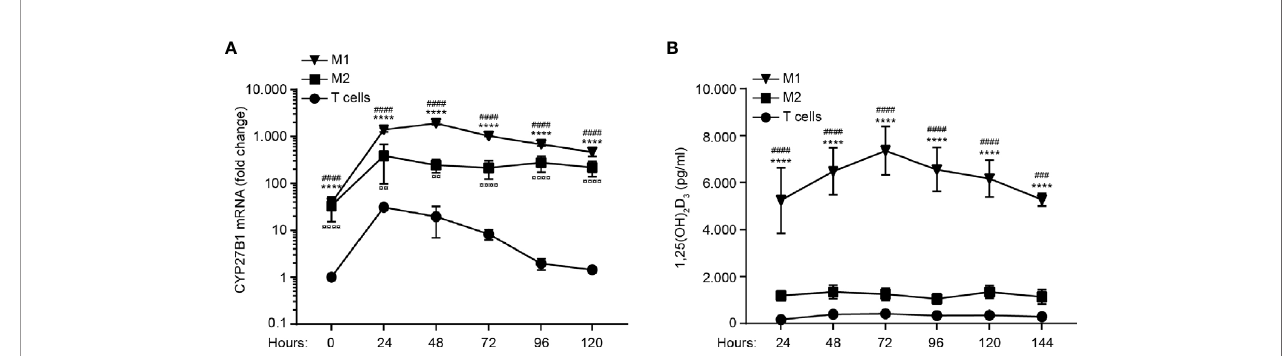
FIGURE 2 | M1 macrophages strongly up-regulate CYP27B1 and produce more 1,25(OH) 2 D 3 than M2 macrophages and CD4 + T cells. Relative mRNA expression of CYP27B1 (A) and production of 1,25(OH) 2 D 3 (B) in M1 and M2 macrophages and CD4 + T cells activated with LPS and IFN g , LPS and Dynabeads Human T-activator CD3/CD28, respectively, for 0 to 120 hours in the presence of 100 nM 25(OH)D 3 . Data in (A) are normalized to CYP27B1 in CD4 + T cells at time zero and were obtained from three independent experiments with nine donors (3 T cell donors, 3 M1 macrophage donors and 3 M2 macrophage donors). Data in (B) were obtained from three independent experiments with 17 donors (6 T cell donors, 6 M1 macrophage donors and 5 M2 macrophage donors). *M1 macrophages versus T cells; # M1 macrophages versus M2 macrophages; ¤ M2 macrophages versus T cells. (A, B) Data (mean ± SEM) were tested by use of two-way ANOVA with post hoc multiple comparisons test (Tukey ’ s).